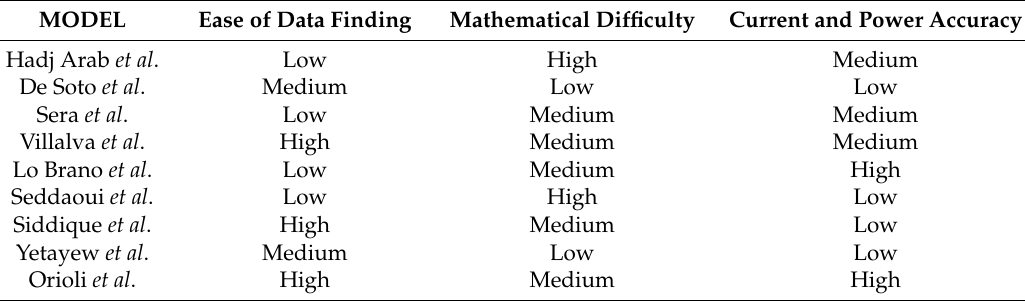
Table 18. Usability and accuracy rating of the analysed one-diode models. MODEL Ease of Data Finding Mathematical